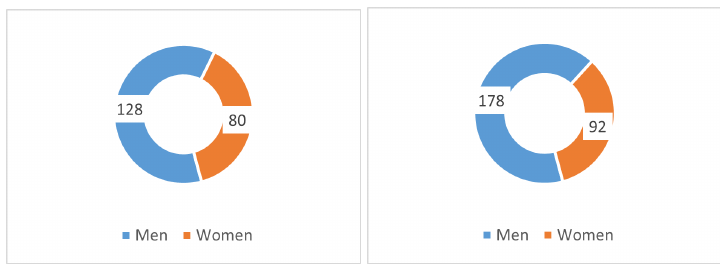
Figure 2. Distribution of victims by age of the control and main